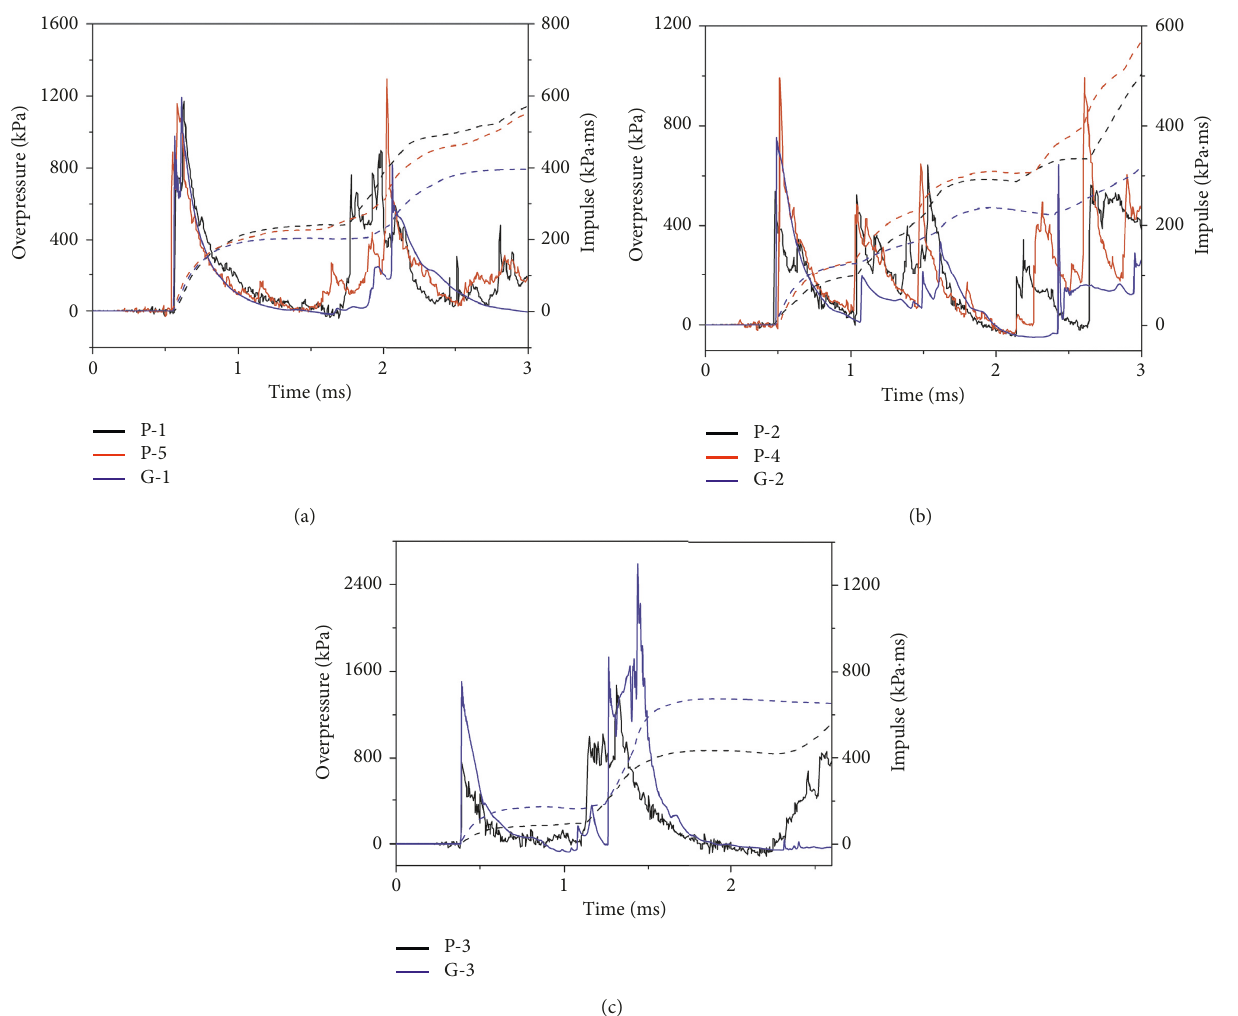
Figure 16: Comparisons between test data and numerical simulation data of scenario T4. Comparison between (a) test and simulation (P1 & P5), (b) test and simulation (P2 & P4), and (c) test and simulation (P3).